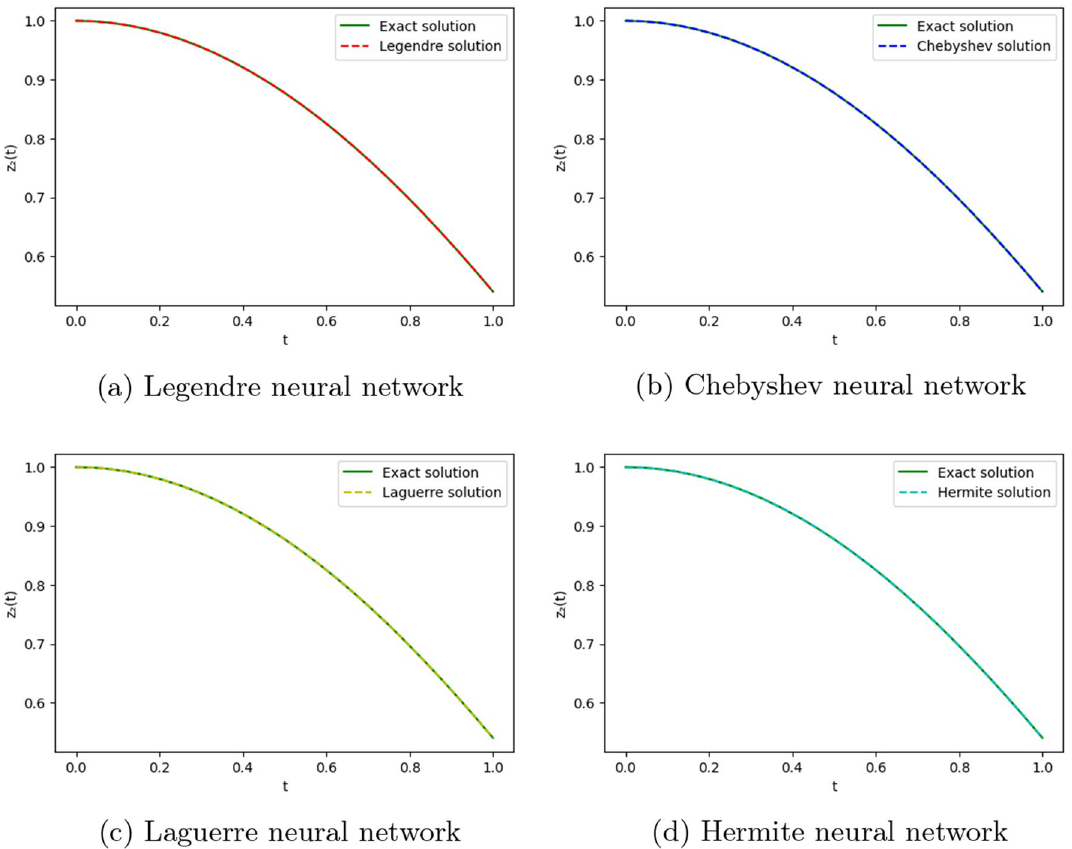
Figure 18. Comparison of the exact solution z 2 ( t ) with the obtained approximate solutions of Example